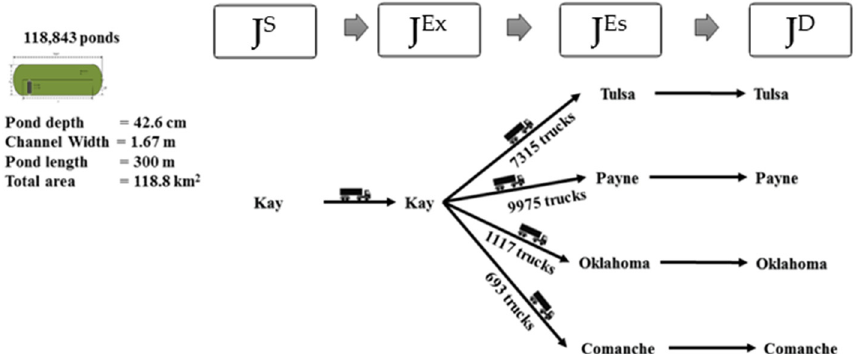
Figure 12. Supply chain optimization for the State of Oklahoma. To replace 25% of the diesel in Oklahoma, the model shows 118,843 ponds are needed in Kay County, with trucking to the demand locations indicated. Table 8. Fuel consumption and demand for the Oklahoma case.